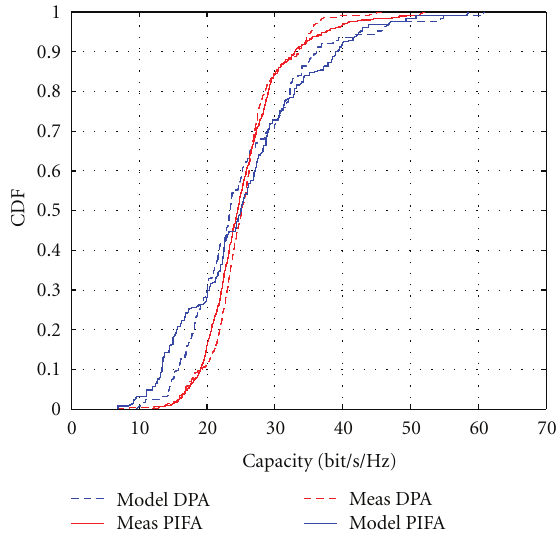
Figure 6: Capacity CDF at SNR